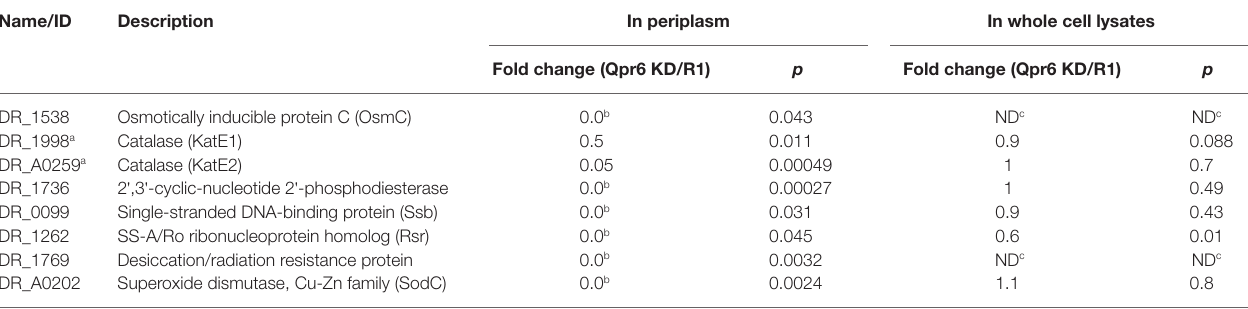
TABLE 1 | Qpr6 affects the transport of proteins important to oxidative stress response to the periplasm of D. radiodurans